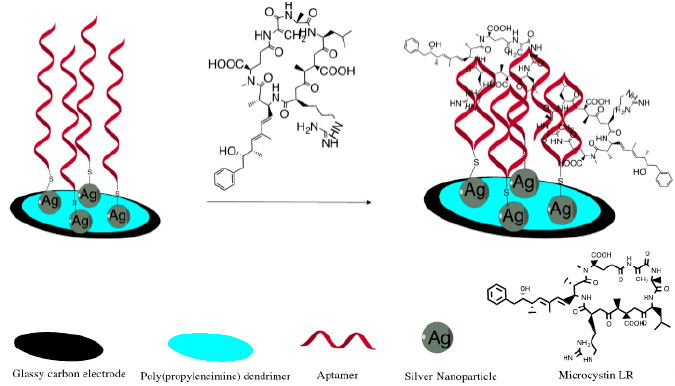
Figure 2. Schematic representation of cobalt(II) salicylaldiimine metallodendrimer aptatoxisensor preparation.